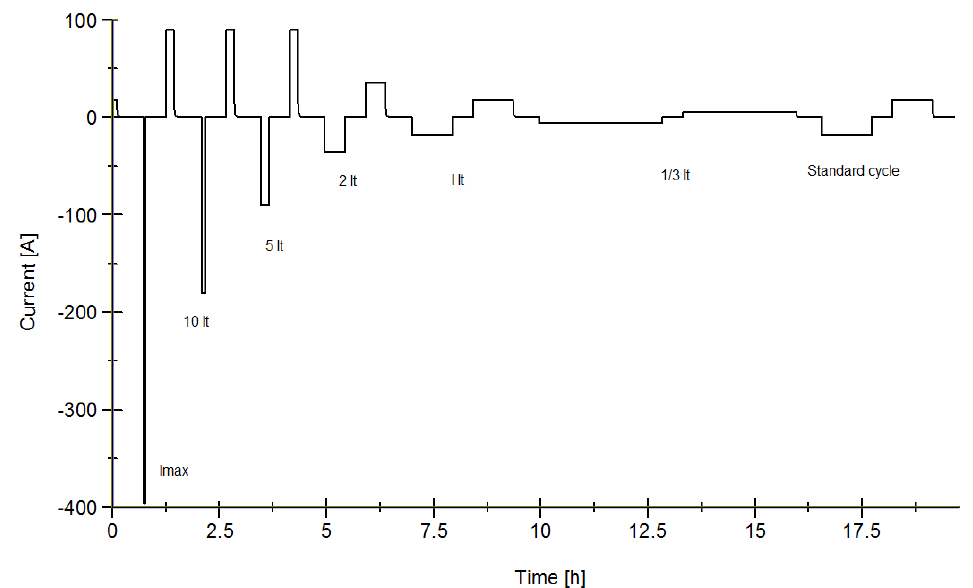
Figure 5. Newly developed energy and capacity test at different current rates.